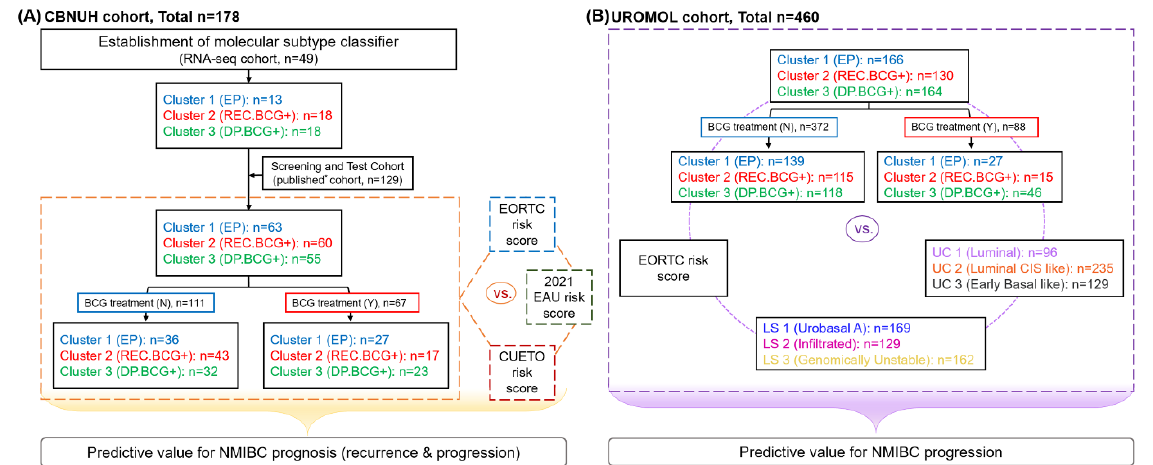
Figure 5. Overall study design. ( A ). Comparison of MSP888 clusters with the EORTC, CUETO and 2021 EAU risk scores for predicting NMIBC prognosis (both recurrence and progression) in the CBNUH cohort. ( B ). Comparison of the MSP888 clusters with the EORTC risk score, the UROMOL classifications and Lund subtypes for predicting NMIBC progression in the UROMOL cohort (a European multicenter prospective study). CBNUH, Chungbuk National University; LS, Lund subtype; NMIBC, non‑muscle‑invasive bladder cancer; UC, UROMOL classification.